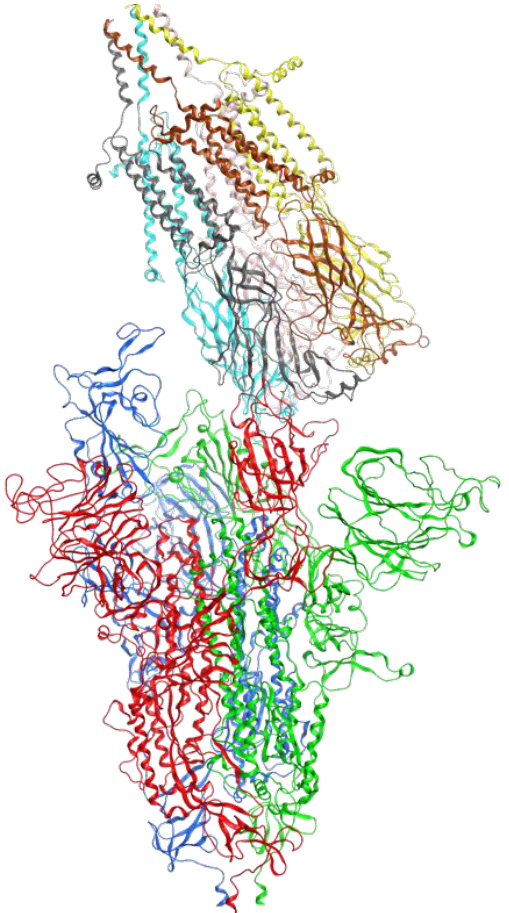
Figure 6. Spike –α7nAChr complex model. Spike protein trimer is colored in dark blue (chain A), red (chain B) and green (chain C). α7nAChr pentamer is colored in cyan (chain A), pink (chain B), yellow (chain C), brown (chain D) and gray (chain E). The yellow and green parts of α7nAChr are interacting with the dark blue and gray monomers from spike protein. Chain B (red) and chain C (green) of α7nAChr are interacting with the chain A(cyan) and chain E(gray) of spike protein.